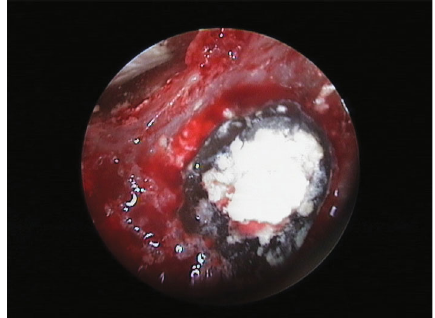
Figure 11: Endoscopic view of 1.1 after removal of the old fi ller material and checking of retrograde cavity integrity.